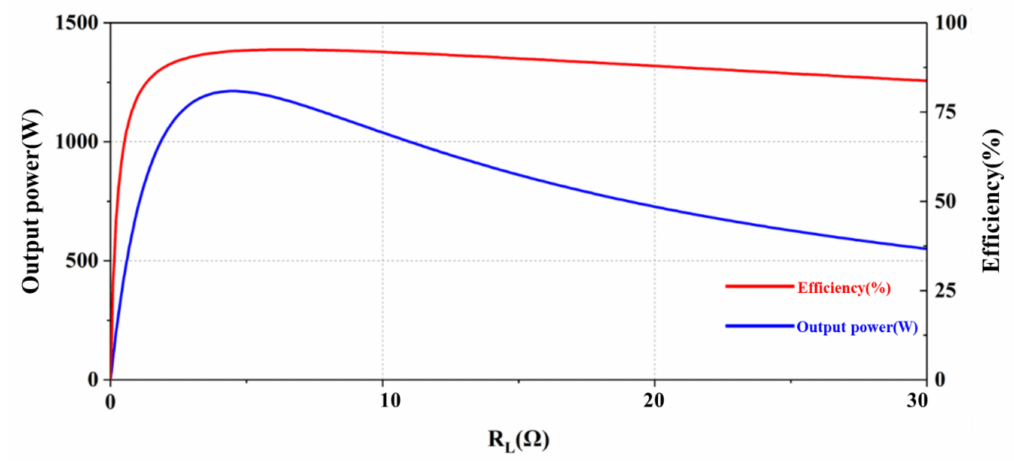
Figure 5. Variation of output power and efficiency with load resistance for the S-S